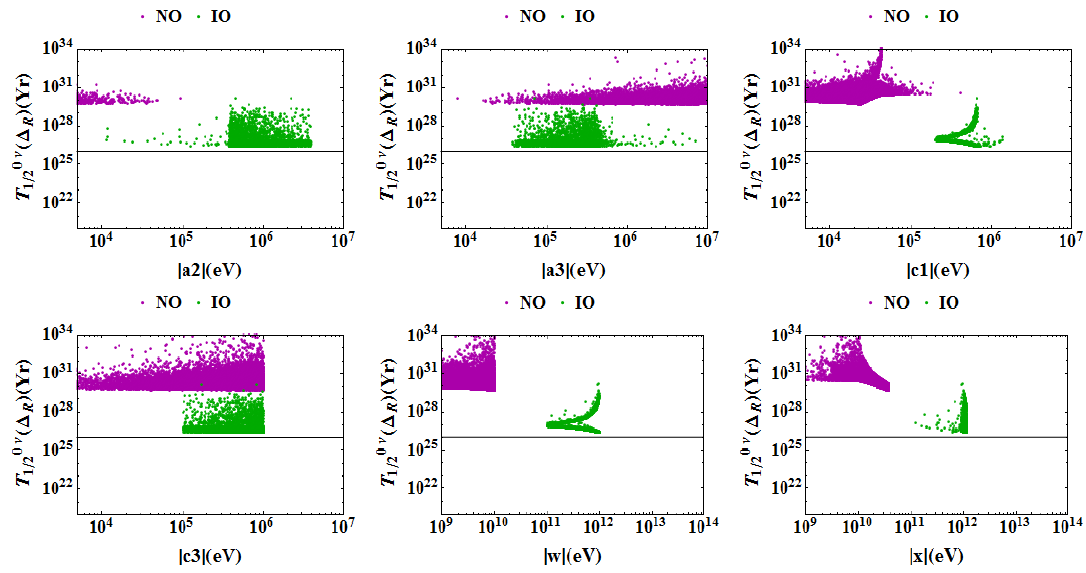
JHEP06(2019)064 Figure 16 . Heavy (cid:1) R contribution to half-life governing NDBD as a function of model parameters for the class B3. The horizontal line represents the KamLAND-Zen lower limit. Figure 17 . Heavy (cid:23) (N) contribution to half-life governing NDBD as a function of model param- eters for the class B4. The horizontal line represents the KamLAND-Zen lower limit. { 27